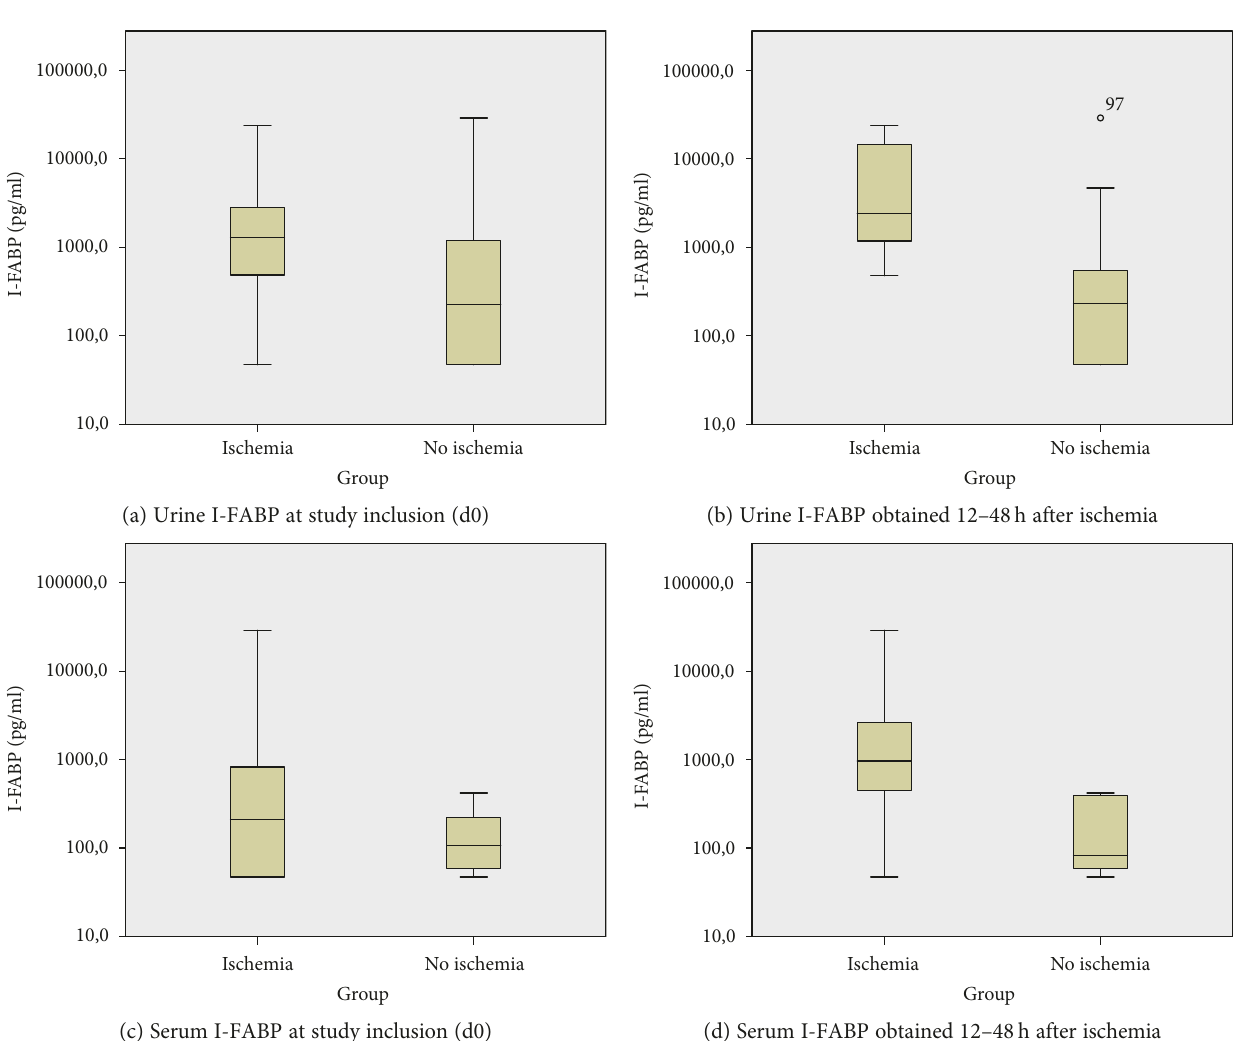
Figure 2: I-FABP at day 0. Comparison of urine and serum samples of both groups. The statistical signi fi cance was higher in samples taken 12 to 48 hours after the event that most likely triggered ischemia. Logarithmic